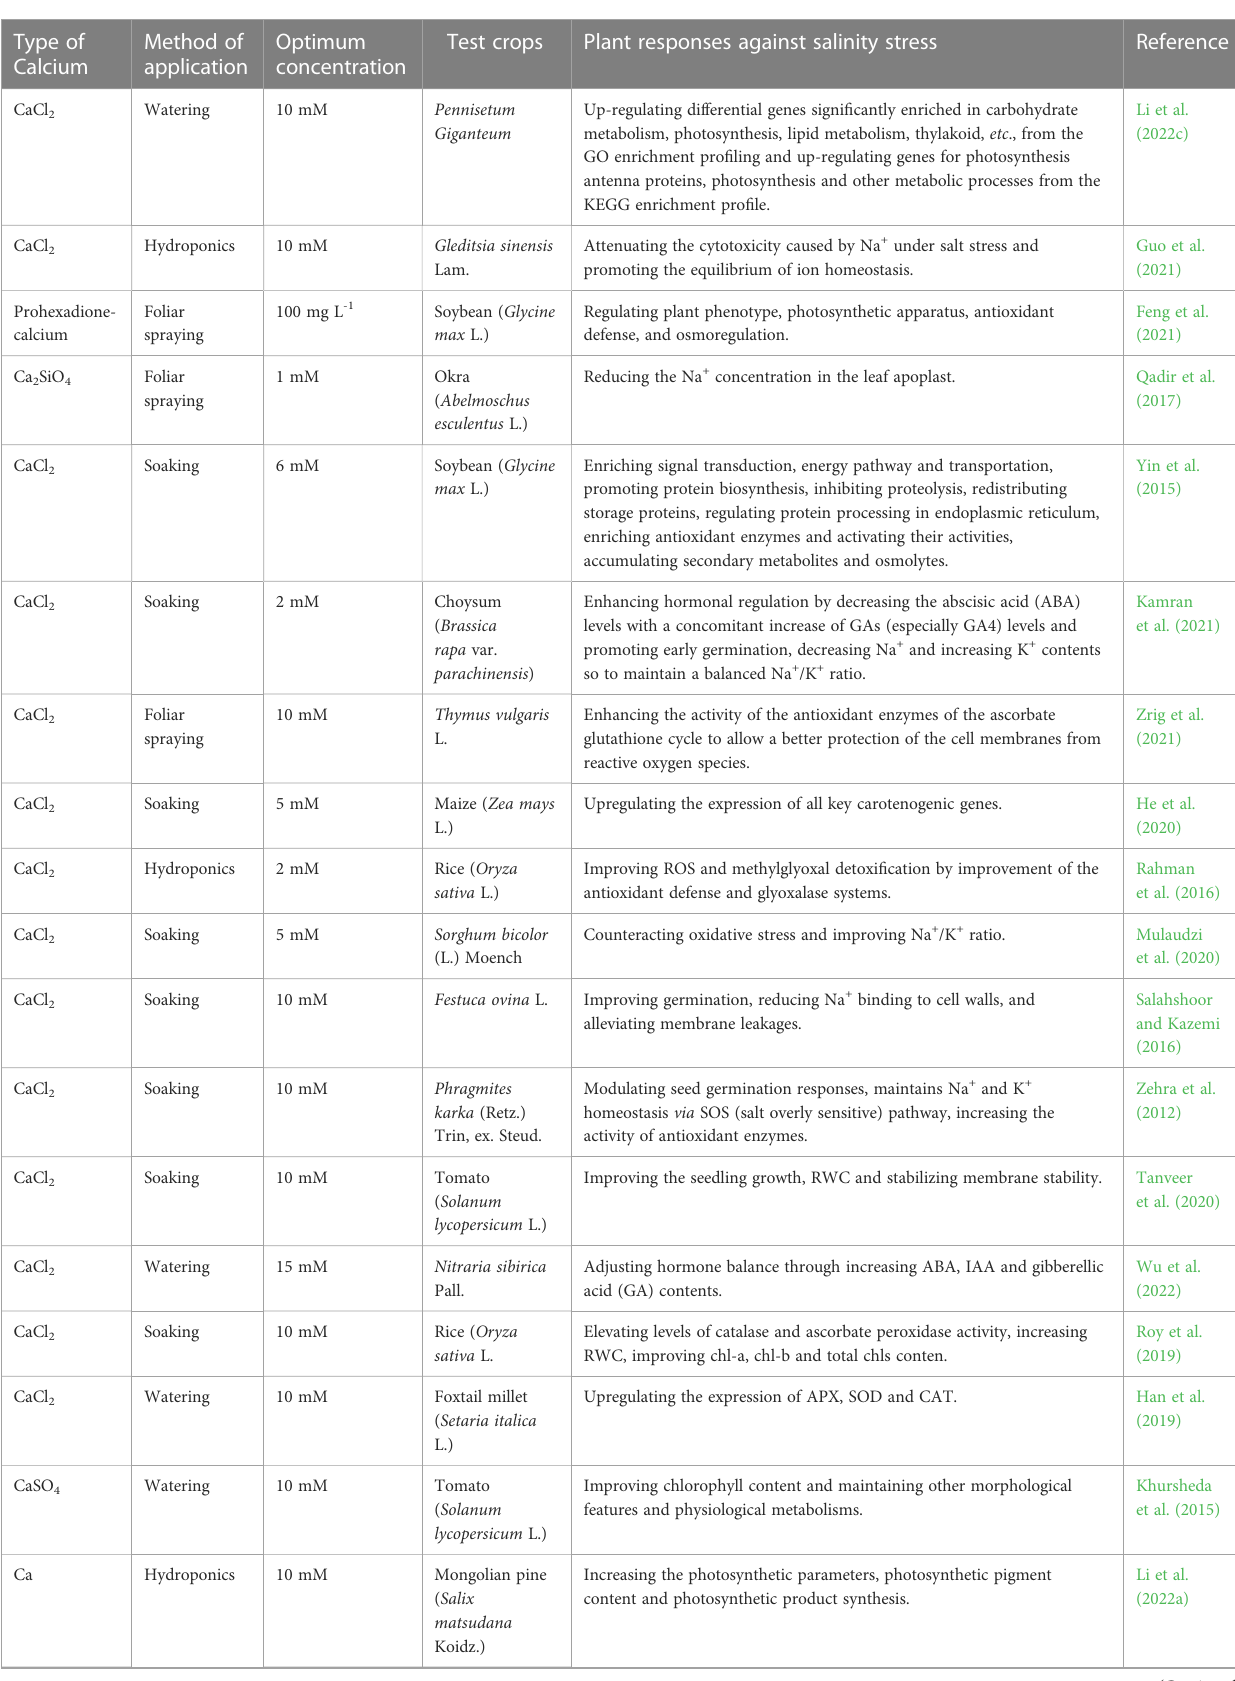
TABLE 3 List of optimal concentrations of exogenous calcium used to alleviate salinity stress in different